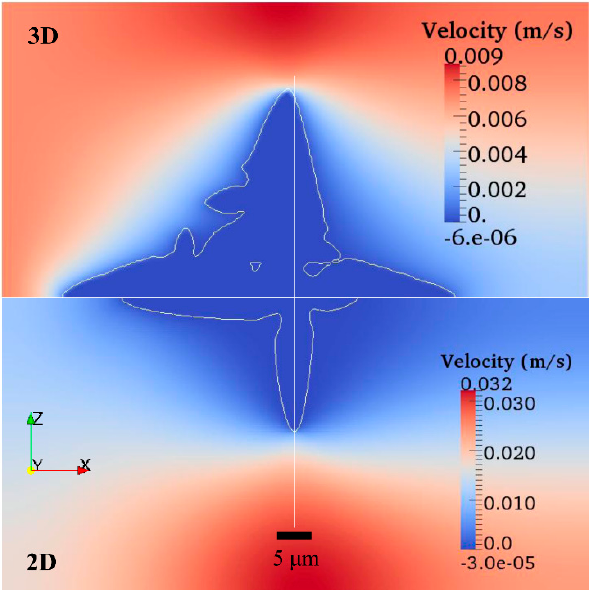
Figure 9. Color map and zero contour showing the x-component of velocity around 2D (lower) and 3D (upper) dendrites.